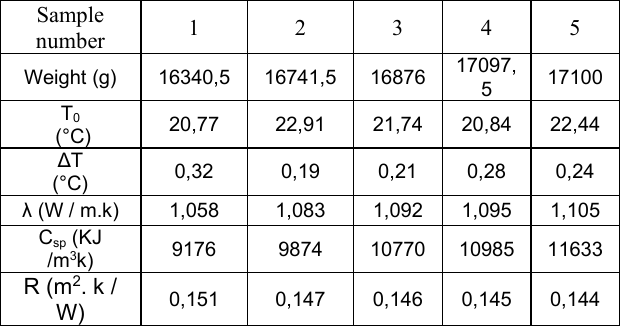
Table 3. The results of thermal experiments for concrete blocks